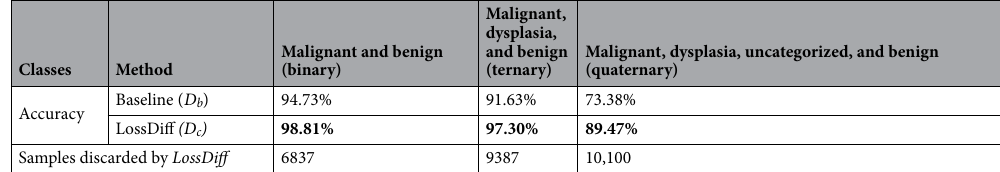
Table 7. Accuracy comparison between the baseline and LossDiff results for ternary and quaternary classes. Significant values are in bold.